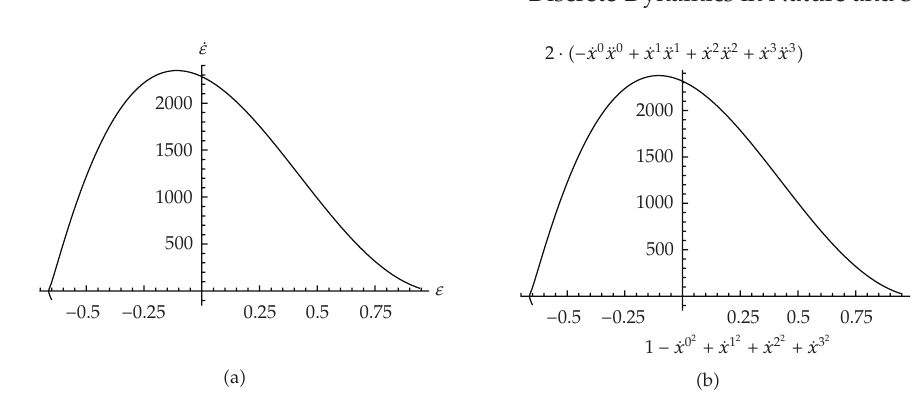
Figure 1: (cid:6) a (cid:7) First set, the autonomous equation trajectory. (cid:6) b (cid:7) First set, the orbit equation trajectory.